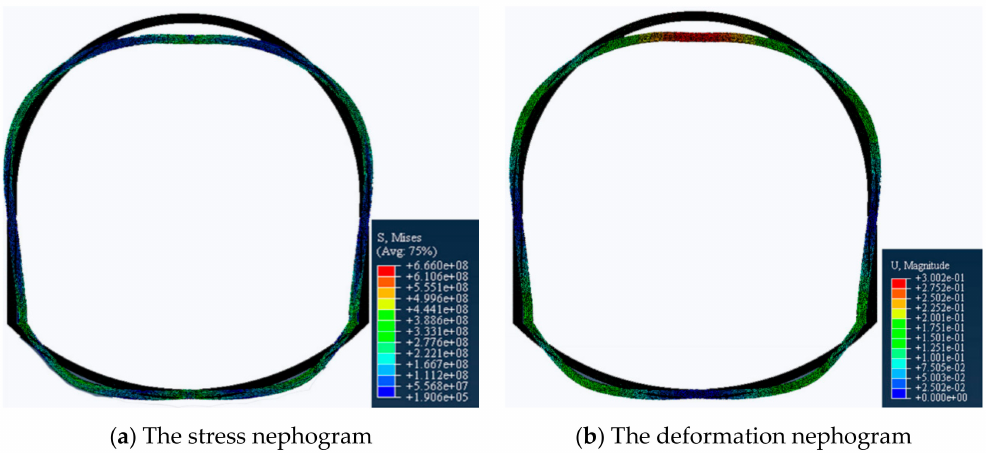
Figure 9. The stress nephogram and the deformation nephogram of the traditional